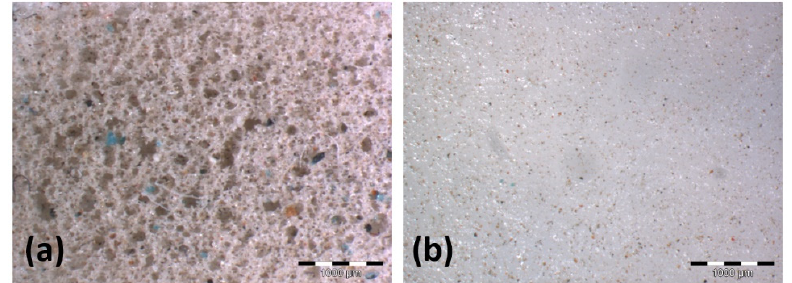
Figure 11. ( a ) OM image (25×) of the PU sponge after cleaning at the interface of green sample (set n.1); ( b ) OM image (25×) of the PG6 after cleaning at the interface of blue sample (set